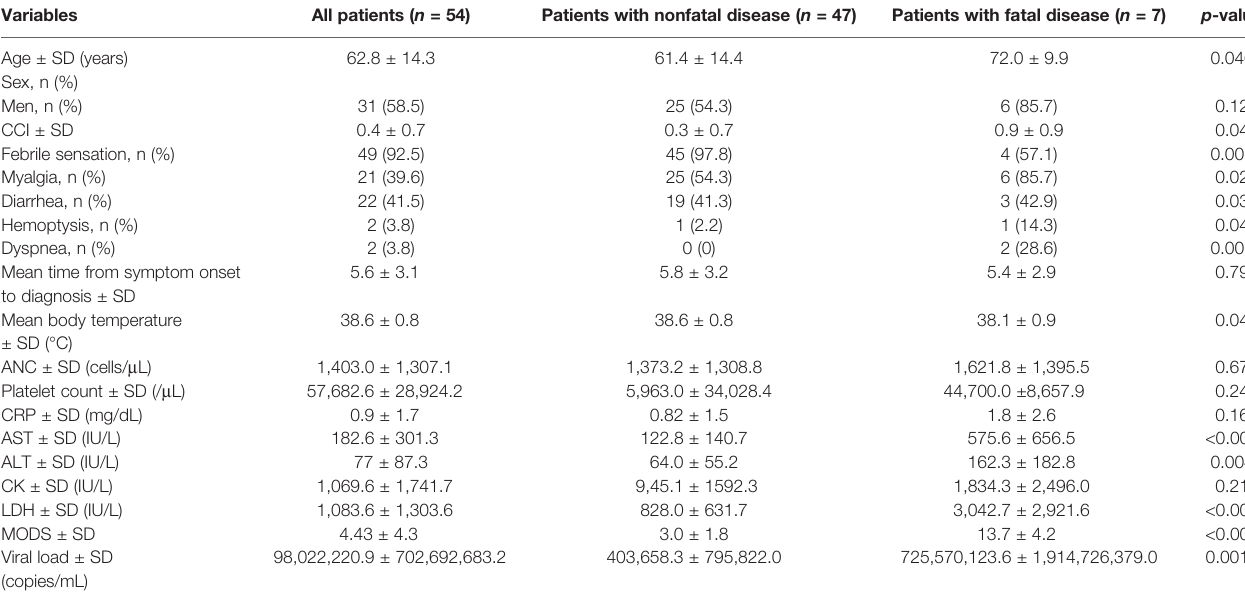
TABLE 1 | Demographics and baseline characteristics of patients infected with SFTSV in Jeju, South Korea, from 2013 to 2019 ( n =54). Variables All patients ( n = 54) Patients with nonfatal disease ( n =